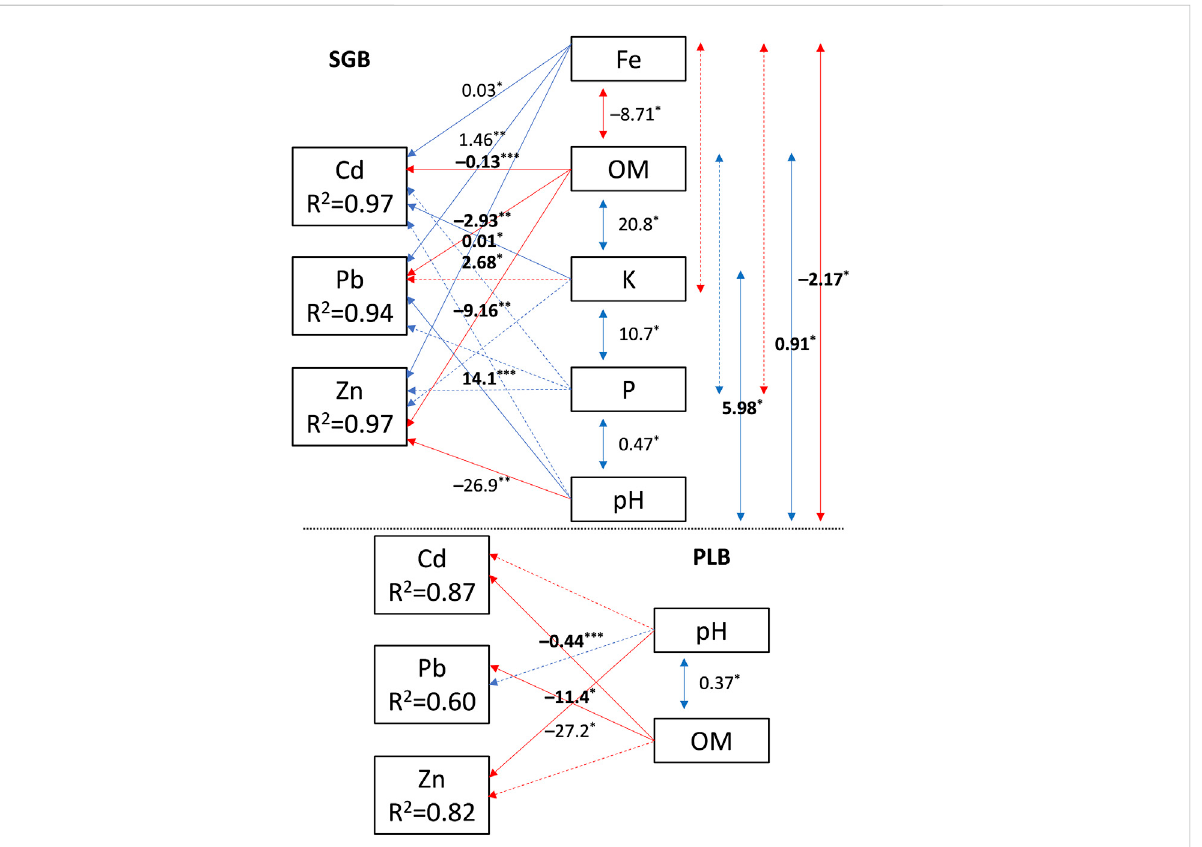
FIGURE 7 Path diagram for the relationship between soil attributes and metals availability. R 2 denotes the coef fi cient of determination for Squared Multiple Correlations. The direct effects ofsoil attributes on metals availability are represented by single-headed arrows while theindirecteffects of soil attributes are shown by double-headed arrows. Numbers near the arrows are the path coef fi cients (unstandardized solution). The solid-line path indicates that the effect is signi fi cant, and a dashed-line path indicates that the effect has no signi fi cance. Blue and red represent positive and negative correlations, respectively. SGB and PLB are switchgrass- and poultry litter-derived biochar, respectively. *: p < 0.05; **: p < 0.01; ***: p <